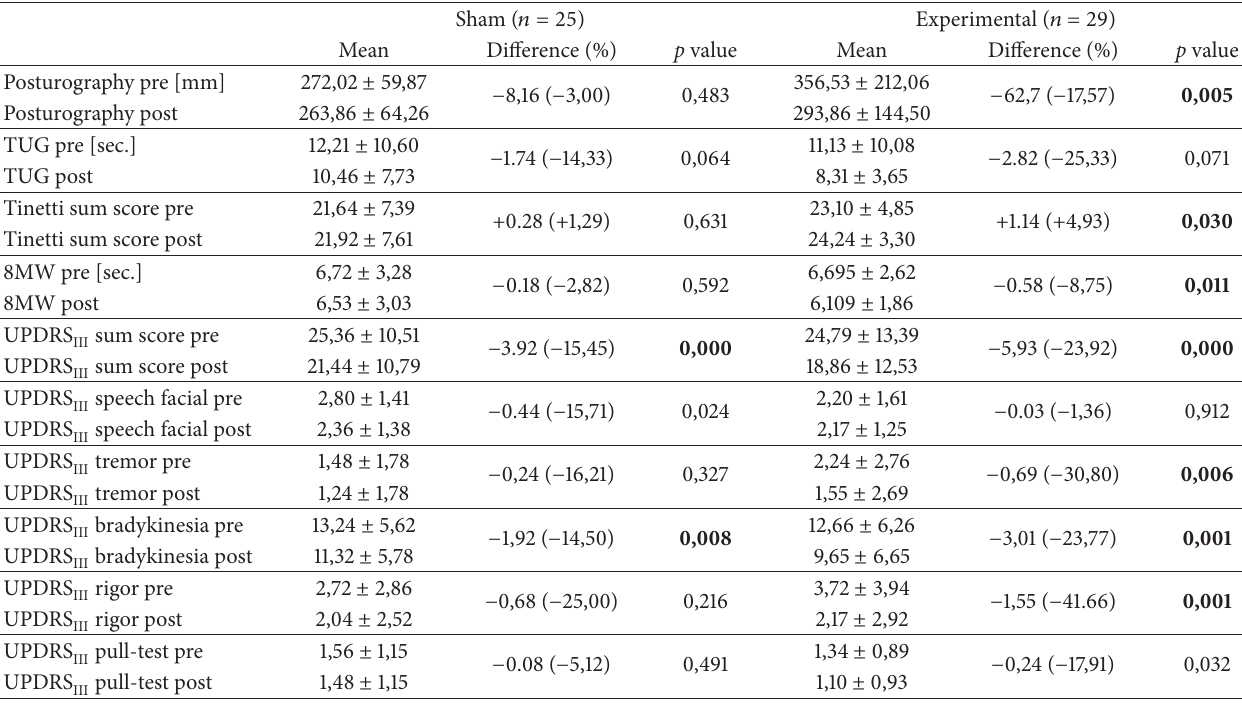
Table 3: Effect of whole body vibration at baseline and after treatment (within-group comparison).